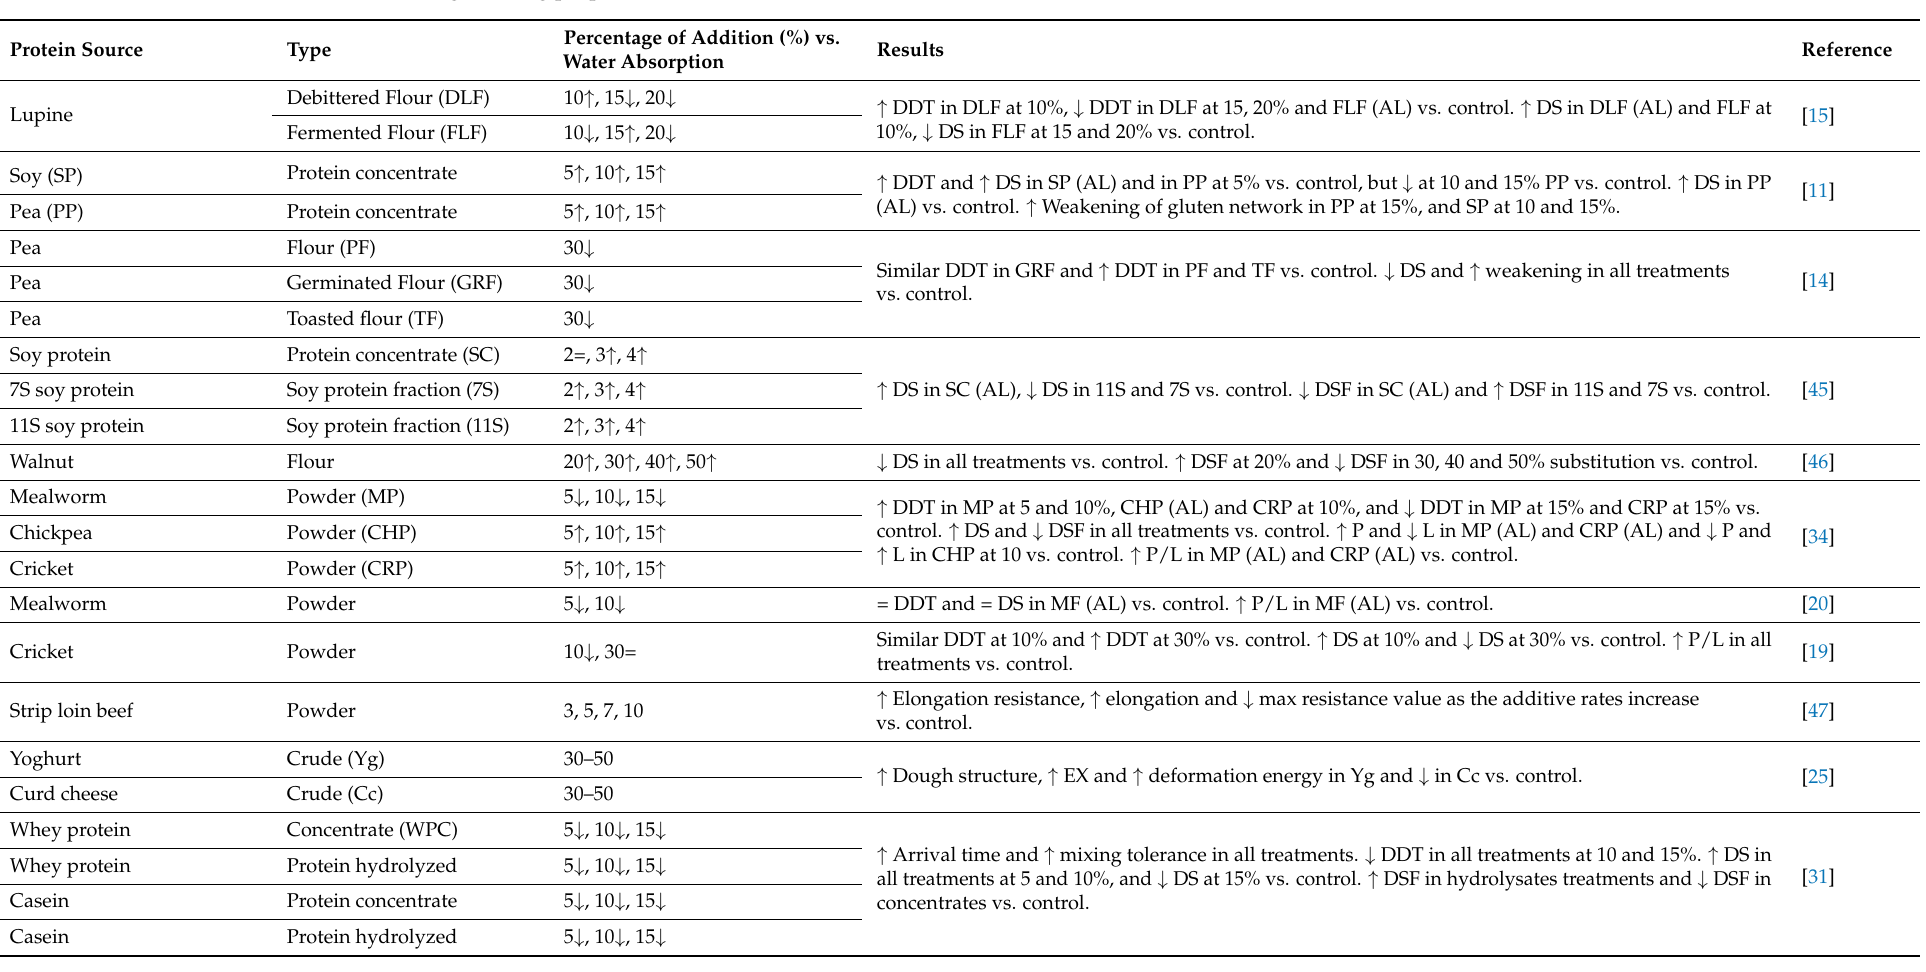
Table 2. Dough mixing